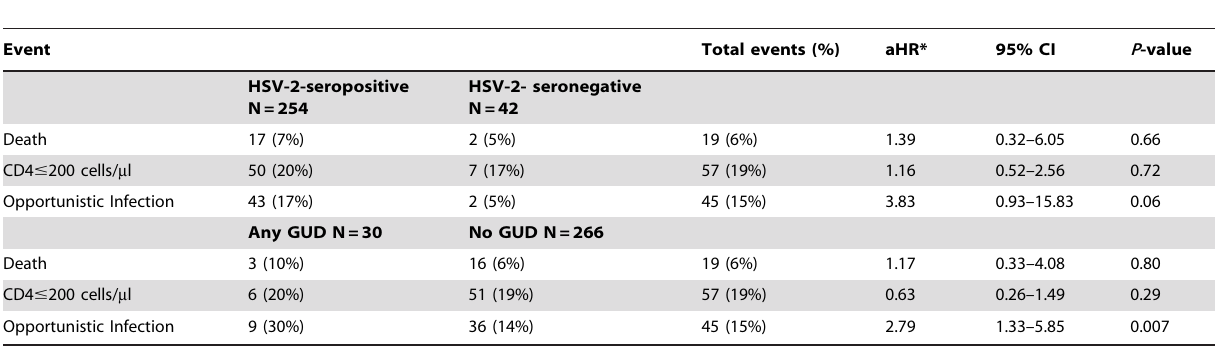
Table 2. Risk of Postpartum HIV-1 Progression Event by HSV-2 Serostatus and GUD.